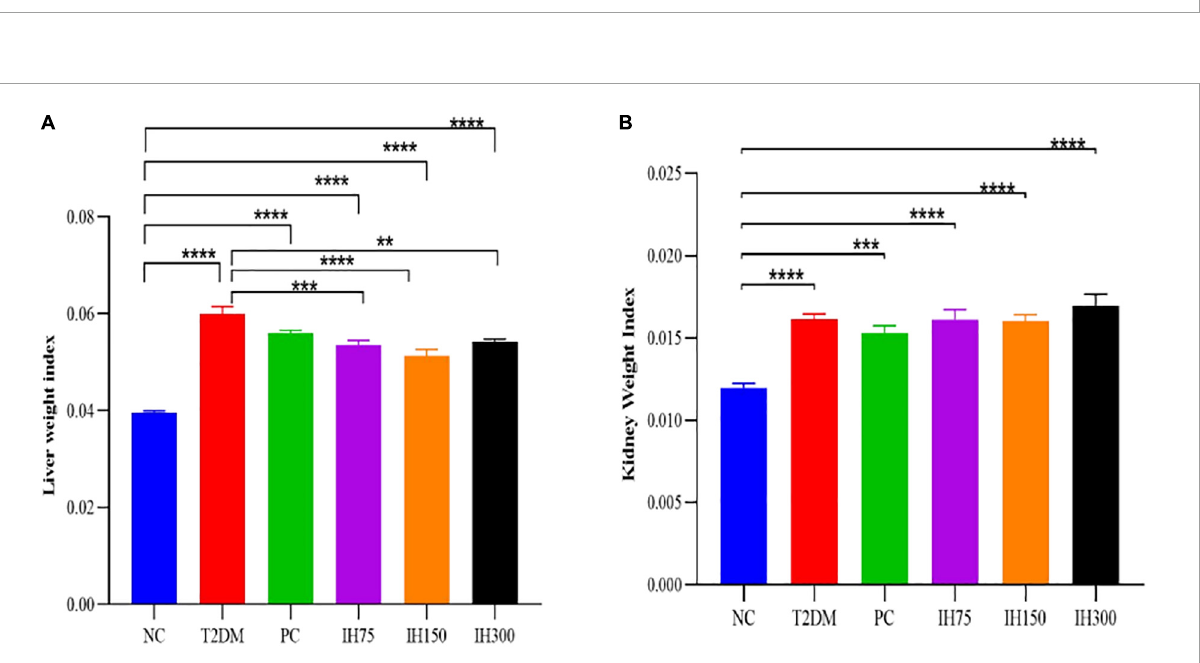
FIGURE3 Effects of IH on liver weight index (A) and kidney weight index (B) in mice. All data are expressed as mean ± standard error of the mean (SEM). N = 6, P < 0.01 (**), P < 0.001 (***), and P < 0.0001